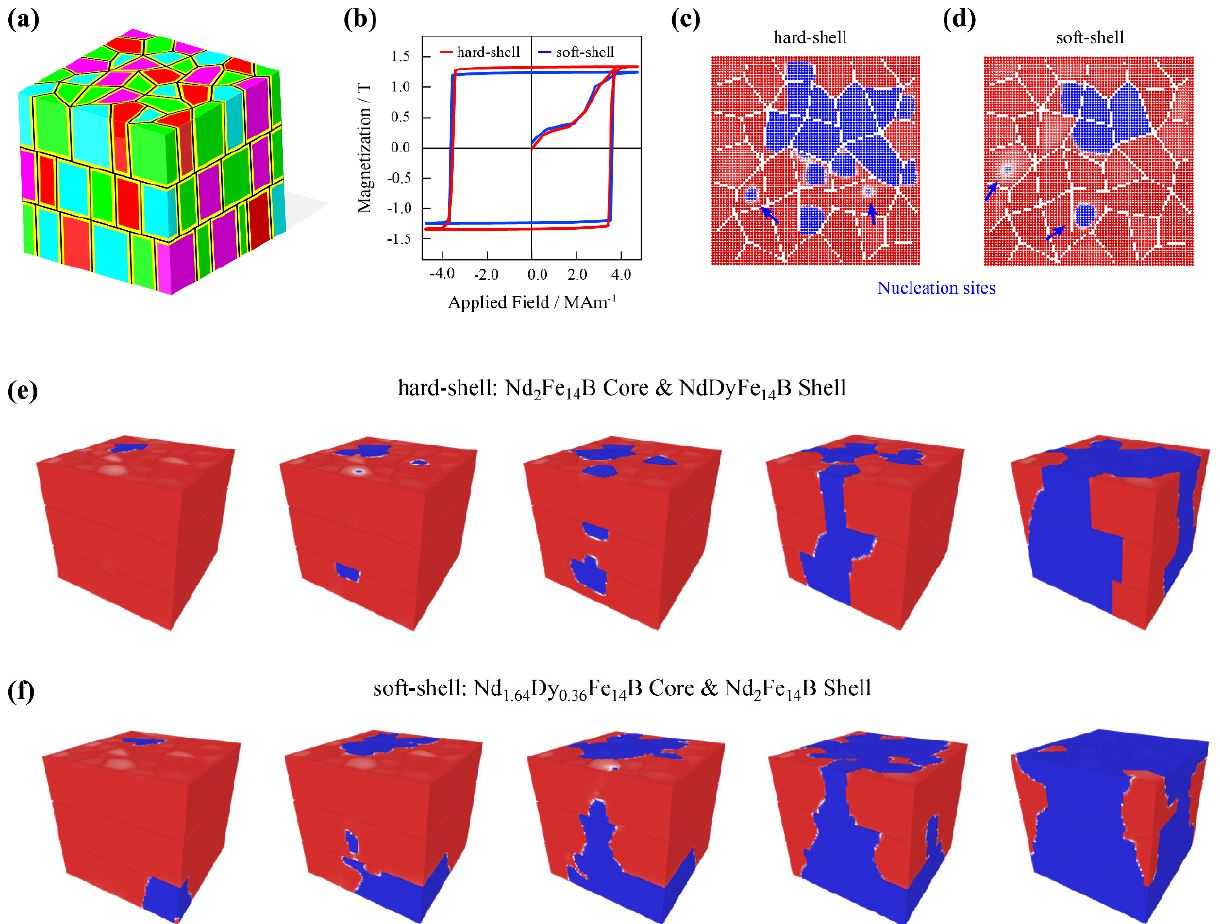
Figure 6. Simulated magnetization reversals of the 3D micromagnetic models with core-shell grains. ( a ) Schematic 3D model consisting of polyhedral core-shell grains. ( b ) Hysteresis loops of models with hard and soft shells. ( c , d ) Two-dimensional selected plane capture from 3D domain structures of hard- and soft-shell models during demagnetization. ( e , f ) Three-dimensional domain structures of hard- and soft-shell models during the propagation of reversed domains. Hard- and soft-shell grains consisting of an Nd 2 Fe 14 B core with an NdDyFe 14 B shell, and an Nd 1 . 64 Dy 0 . 36 Fe 14 B core with an Nd 2 Fe 14 B shell.